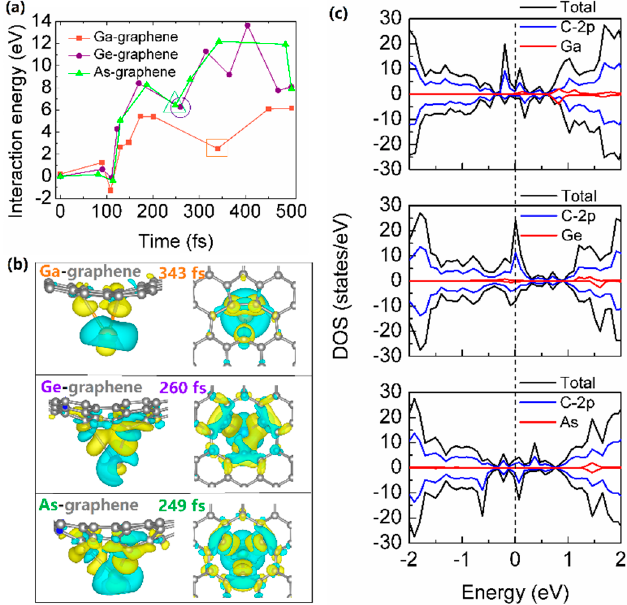
Figure 5. ( a ) The interaction energies between incident Ga/Ge/As atom and graphene. Note that the irradiation-induced distorted graphene lattice is produced after about 100 fs, as depicted in Figure 4b. The charge density difference ( b ) and density of states ( c ) for the configuration that incident atom past through the plane of graphene with a maximum distance. The charge density of isolated Ga/Ge/As plus that of isolated distorted graphene is subtracted to the charge density of the full Ga/Ge/As-graphene system. The isosurfaces of charge density difference are taken to be at 0.01 electrons/Å 3 (yellow represents charge accumulation) and 0.01 electrons/Å 3 (blue represents charge depletion), respectively.